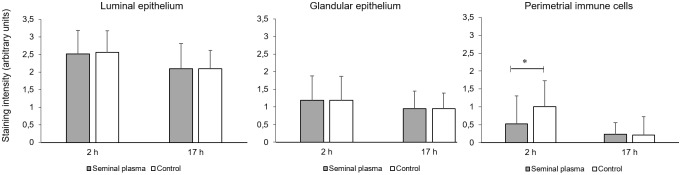
Immunhistochemical staining intensity of PTGS2-positive immune cells in different uterine cell types at 2 h (Group 1, n = 9 gilts) and at 17 h (Group 2, n = 7 gilts) after single uterine horn infusions of seminal plasma and contralateral infusion of PBS. Stain scores: 0 = negative, 1: weak, 2 = positive, 3 = strongly positive).Asterisk indicates a significant difference (P< 0.05).